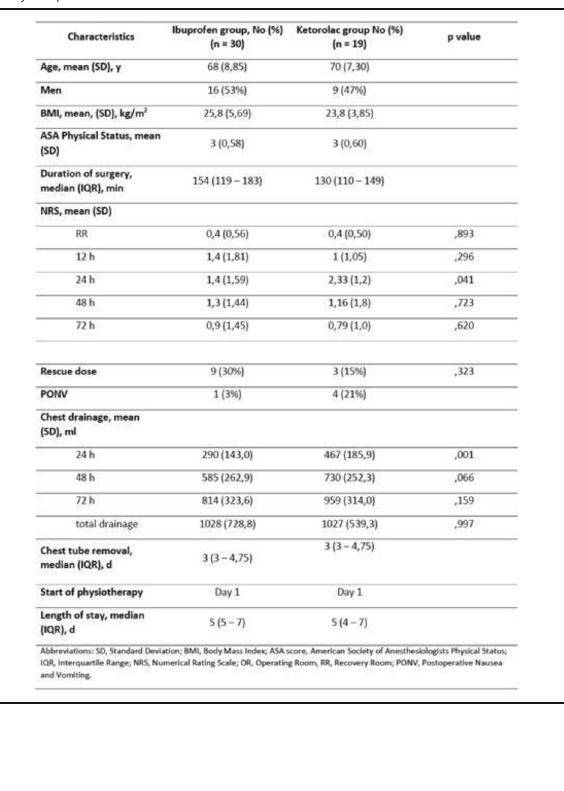
Table 1 (abstract 71). Baseline Demographics and Characteristics of Study Population